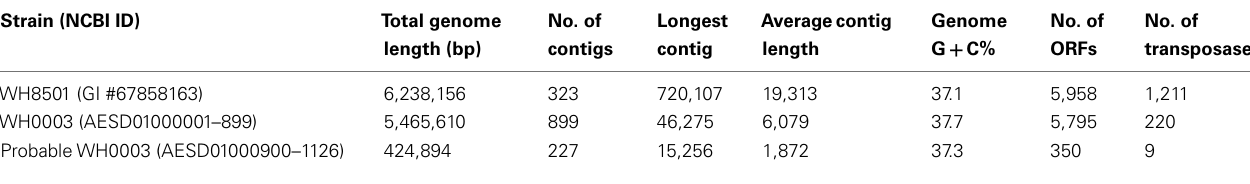
Table 1 | Genome assembly information and annotation summary. Strain (NCBI